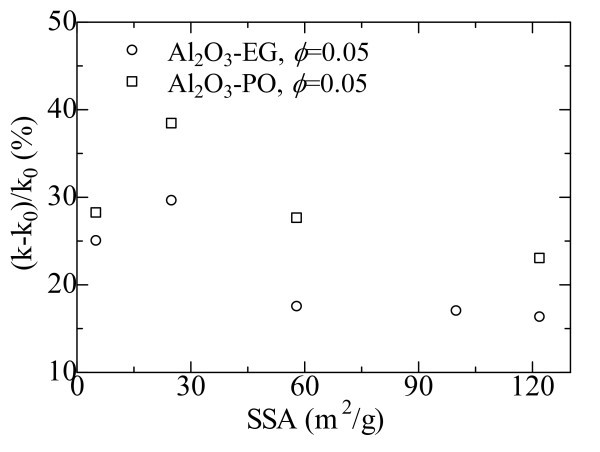
Enhanced thermal conductivity ratios as a function of the SSAs: Al2O3-EG [7]; Al2O3-PO [7].